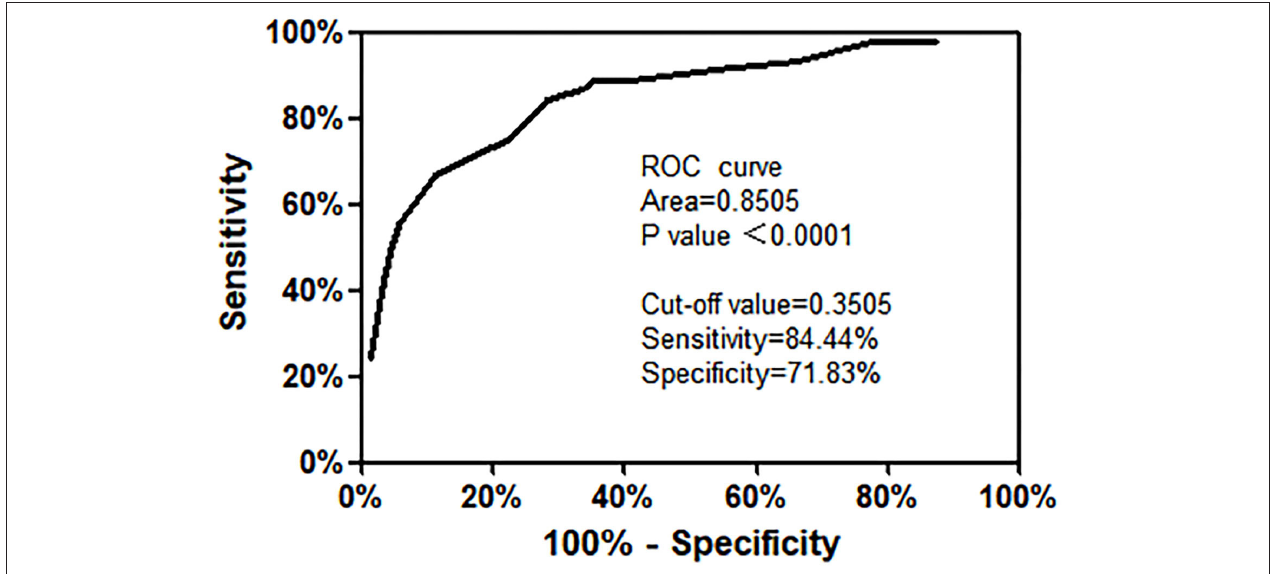
FIGURE 1 | Receiver operating characteristic curve of the risk prediction model for ALL with severe